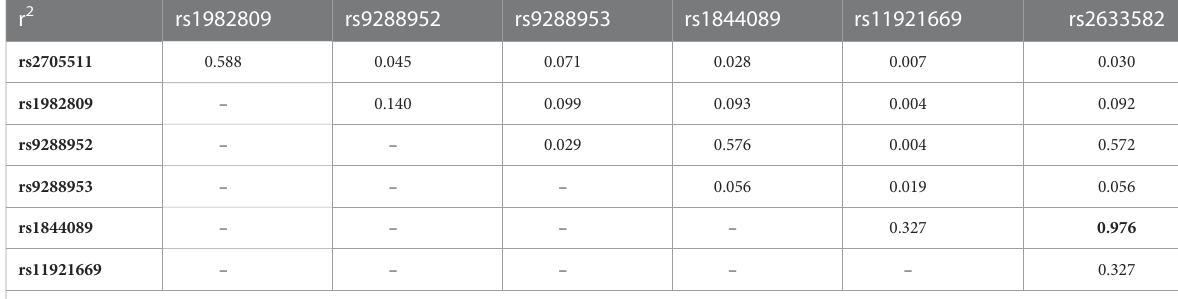
TABLE 3 Linkage disequilibrium between studied BTLA polymorphisms in NSCLC patents and controls. r